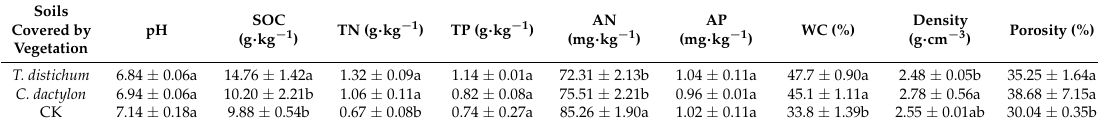
Table 2. Comparisons of soil physicochemical properties under different vegetation types (Means ± SE, n = 3).